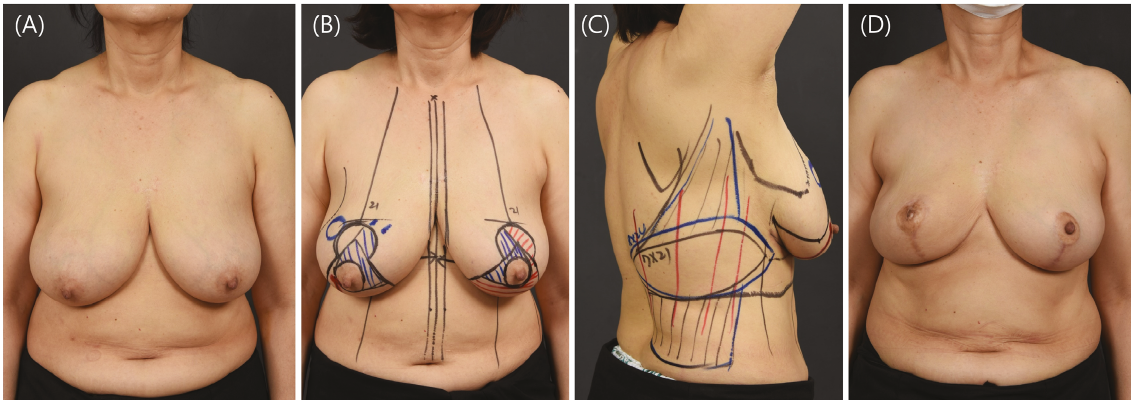
Figure 8: Reduction mammoplasty and nipple or skin-sparing mastectomy (NSSM) in patients with right breast cancer. A patient with a breast cancer tumor in the right upper quadrant of the right breast adjacent to the reduction mammoplasty design is shown. An extended latissimus dorsi (LD) flap with a 7 × 21 cm skin paddle was designed. The excised tissue weight in contralateral reduction mammoplasty was